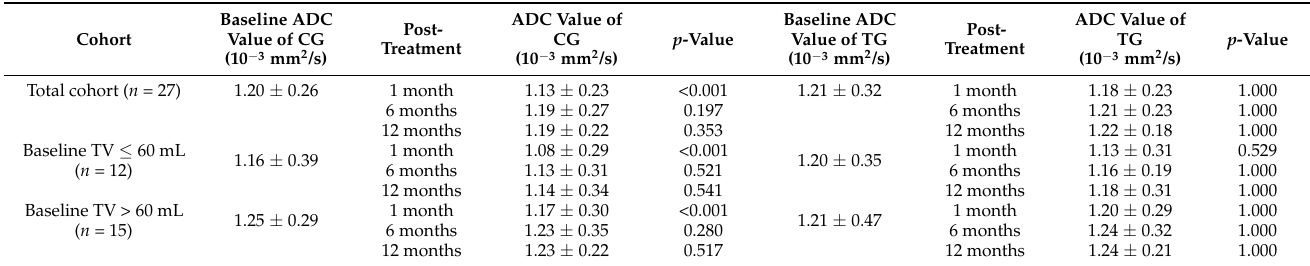
Table 5. Pre- and post-treatment ADC values presented as means ± SD; p -values include Bonferroni multiple testing correction.